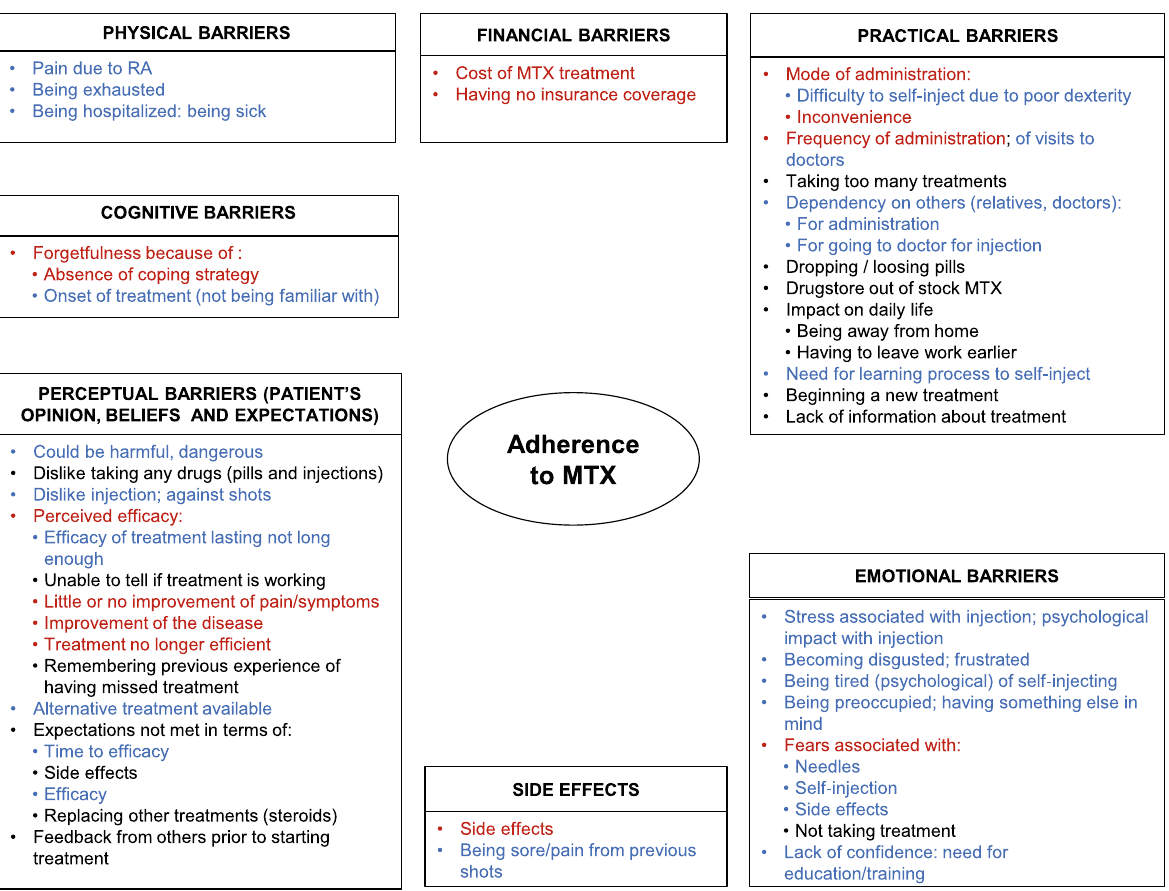
Fig. 1 Conceptual model of the possible barriers specific to MTX adherence. In red, barriers to adherence reported by patients when talking about both injected and oral MTX, in black, barriers to adherence reported by patients when talking about oral MTX only, and in blue, barriers to adherence reported by patients when talking about injected MTX